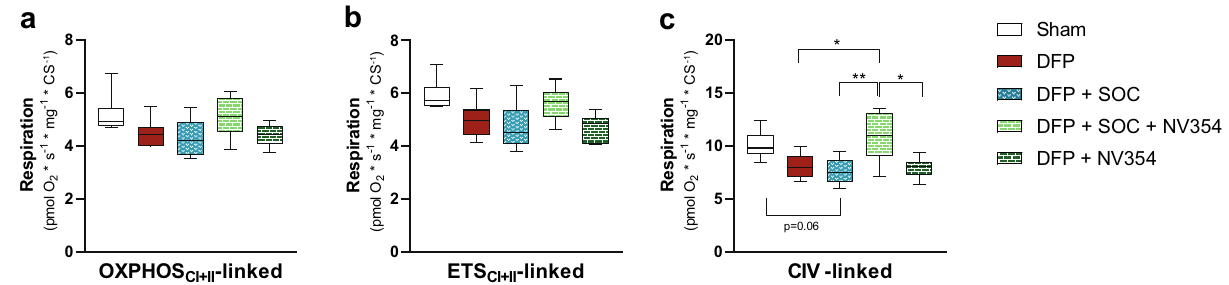
Figure 3. Cerebral mitochondrial respiration. ( a ) Maximal oxidative phosphorylation (OXPHOS) system capacity and ( b ) electron transport system (ETS) capacity supported by mitochondrial complex I and II (CI + II)-linked substrates, as well as ( c ) complex CIV(CIV)-linked mitochondrial respiration supported by the artificial electron donor N , N , N ′ , N ′ -Tetramethyl-p-phenylenediamine dihydrochloride were measured in brain homogenates of sham animals (Sham), untreated animals exposed to diisopropylfluorophosphate alone (DFP), animals exposed to DFP receiving standard of care (SOC) treatment (DFP + SOC), animals exposed to DFP receiving SOC treatment and the cell-permeable succinate prodrug NV354 (DFP + SOC + NV354) and animals exposed to DFP receiving the cell-permeable succinate prodrug NV354 (DFP + NV354). Data are presented as median plus interquartile range, with whiskers indicating minimal and maximal values. Kruskal–Wallis test or One-Way ANOVA was applied for analysis of differences of non-normally distributed and normally distributed data, respectively, with Tukey’s multiple comparison of every group to every other group. *p < 0.05 and **p < 0.01 indicate significant difference between groups. n = 6 per